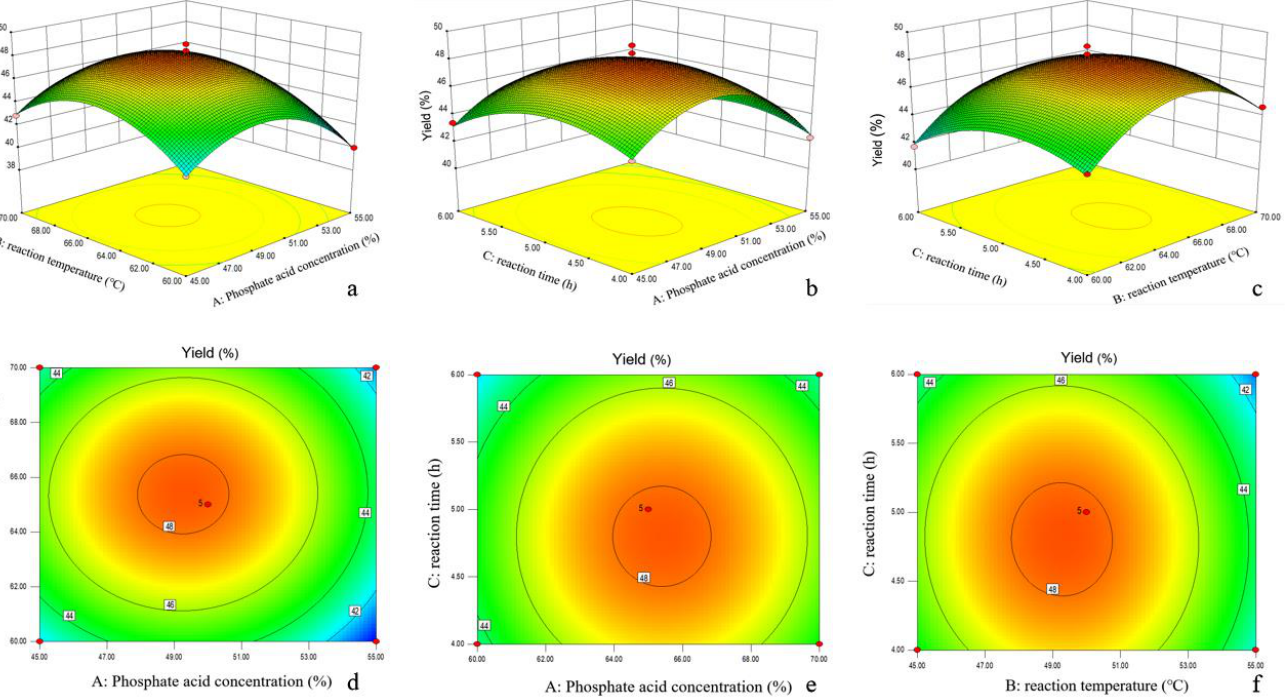
Figure 1. Three-dimensional response surface plots ( a – c ) and corresponding contour plots ( d – f ) of the effect of phosphate acid concentration, reaction temperature, and reaction time on CNCs Yield. The optimum conditions for the CNCs preparation from PSR with the highest yield were identified using Design-Expert. The predicted optimal reaction conditions were an acid concentration of 49.27%, a temperature of 65.38 °C, a time of 5 h, and the prediction yield was 48.33%, which were coherent with the experimental results. CNCs were pre- pared from PSR with a yield of 50.00%, using a phosphoric acid concentration of 49% at 65 °C for 5 h. This is in close ag reement with the model’s results, i.e., within the 95% con- fidence interval, thus validating the sufficiency and accuracy of the model [24]. 3.3. Morphology Analysis The fiber analyzer was used to investigate the changes in morphology and micro- structure of PSR-cellulose and CNCs. As is depicted in Figure 2a,b, both PSR-cellulose and CNCs can be observed with a relatively large L/W ratio and a similar rod-like shape. Fig- ure 2d,e show the length distribution of PSR-cellulose and CNCs calculated by the fiber analyzer, respectively. The length of PSR-cellulose was mainly distributed between 200 and 3524 μm, while the length of CNCs was mainly distributed between 200 and 1031 μm, and 45% of the PSR fibers is longer than 1000 μm, w hich decreases to 5% after hydrolysis. On the other hand, the main distribution range of the CNCs width was between 20 and 60 μm, which is more concentrated than PSR -cellulose (Figure 2f,g). This indicates that